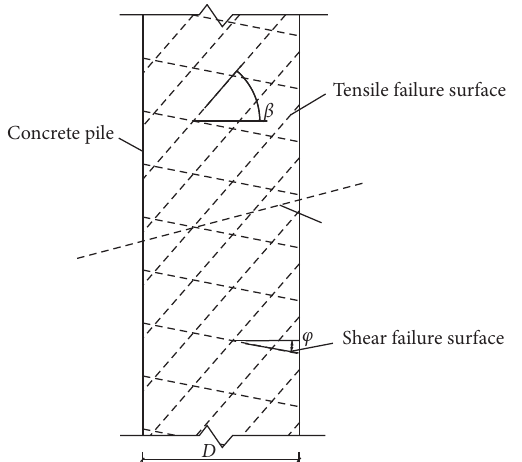
Figure 11: Relationship between sliding surface and actual failure